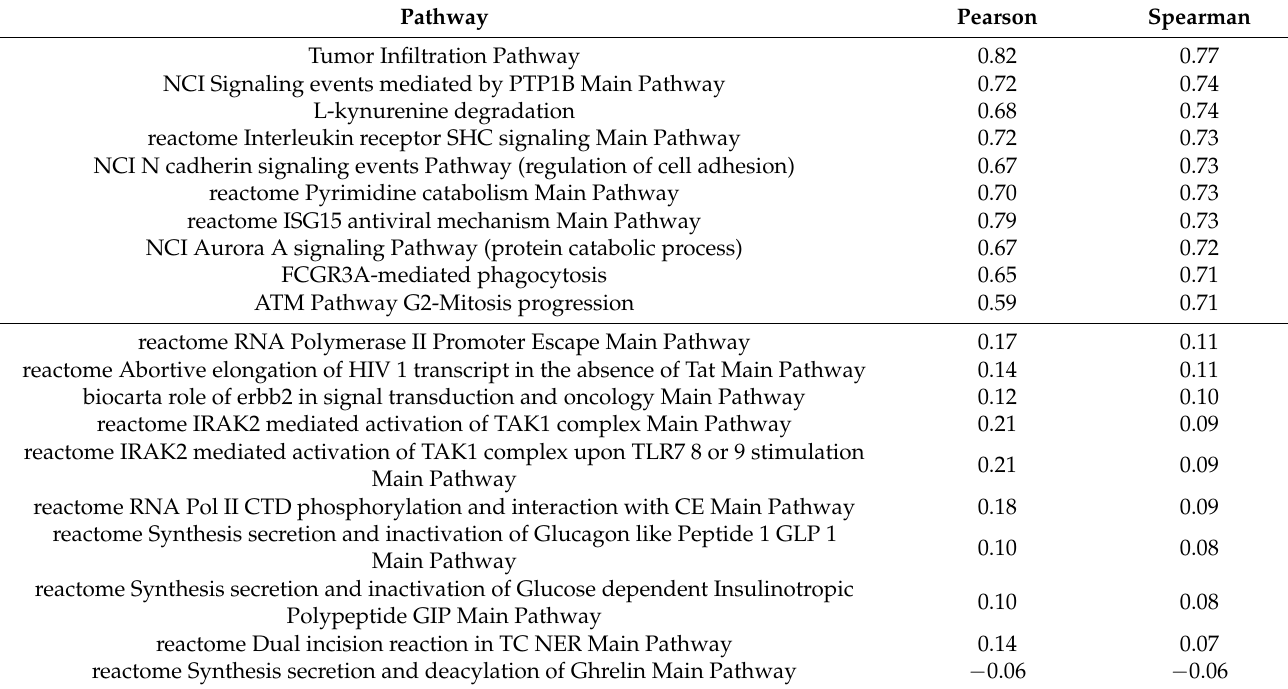
Table 7. “Top-10” of the most and the least correlated molecular pathways between RNA and protein expression levels calculated for Uterine Corpus Endometrial Carcinoma